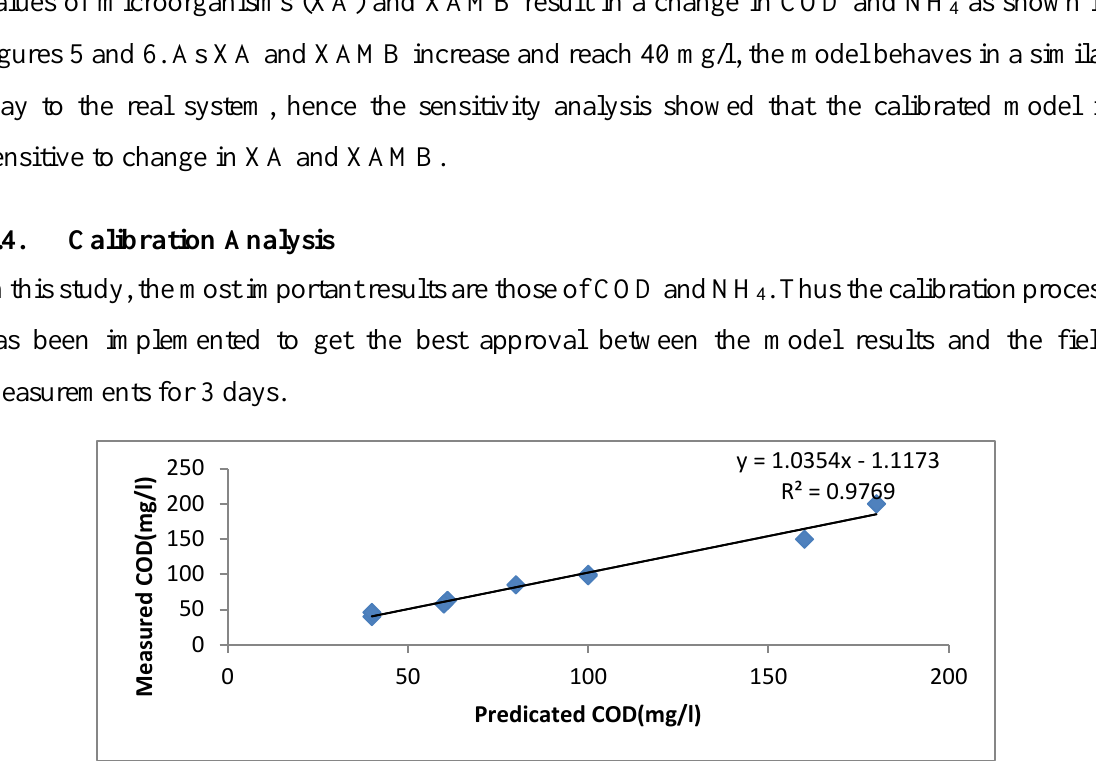
Fig. 5. Comparison between observed and predicted COD after